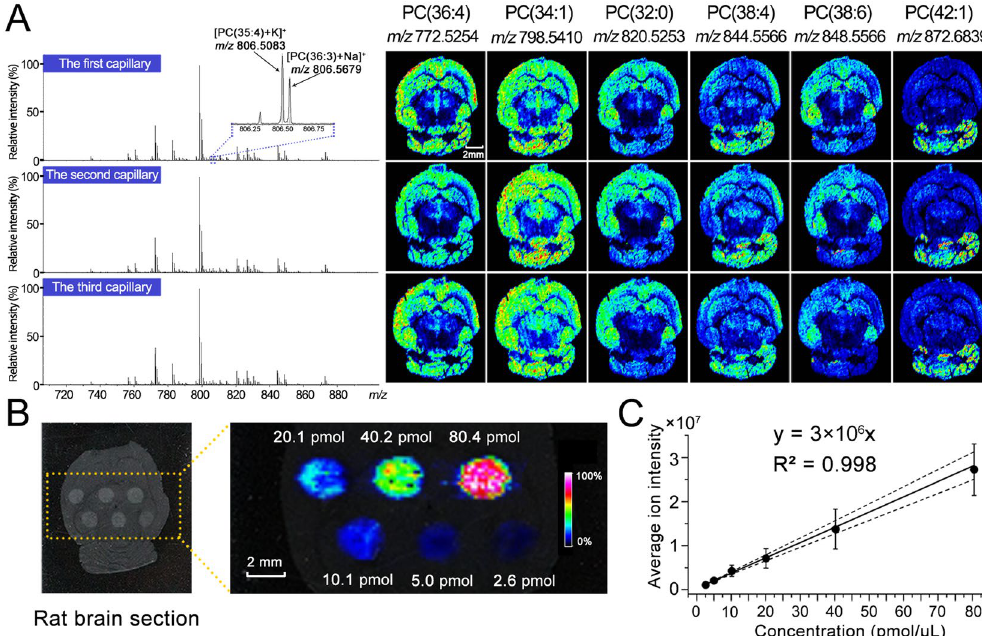
Figure 2. Tissue imaging of mouse brain sections and an exogenous lipid spotted on rat brain section in positive ion mode. ( A ) Average mass spectra and the corresponding ion images obtained from three adjacent tissue sections using three different aspiration capillaries, respectively, in a high mass resolution mode with a mass resolution of 200,000 (at m/z 400) and a spatial resolution of 150 μ m. ( B ) Optical image and MSI result of different amounts (from 2.6 pmol to 80.4 pmol) of [PC(24:0) + K] + ( m/z 600.4001) spotted (1 μ L) on a rat brain tissue section. ( C ) Standard curve by plotting the amounts of each spot against the average intensities of m/z 600.4001 each spot. Error bars represent the standard deviation of the intensity of m/z 600.4001 from about 130 mass spectra in each